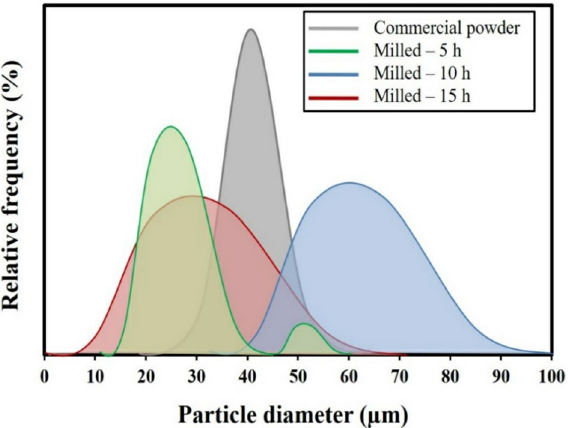
Figure 2. Particle size distribution of the commercial as well as milled MCrAlY powders with different milling durations.